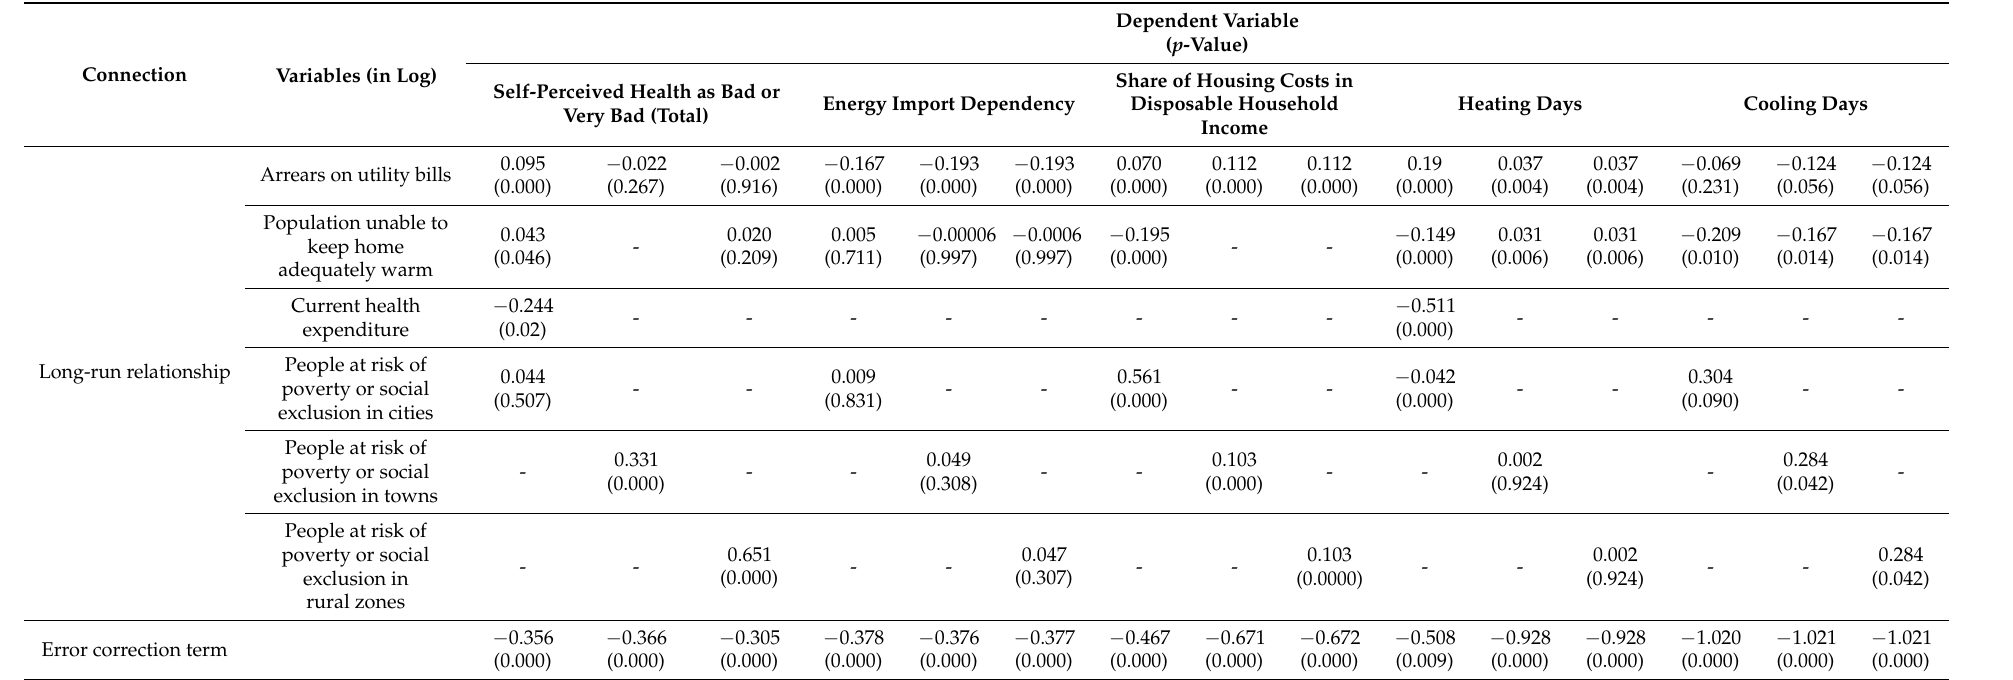
Table 6. Robustness: PMG estimators for additional variables in the case of EU-27 countries